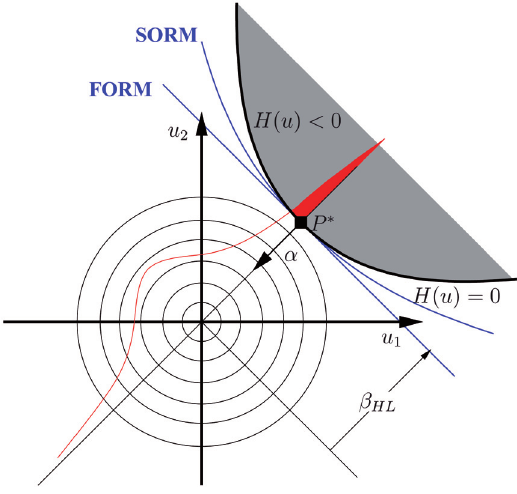
Fig. 1. Approximation methods FORM/SORM in standard